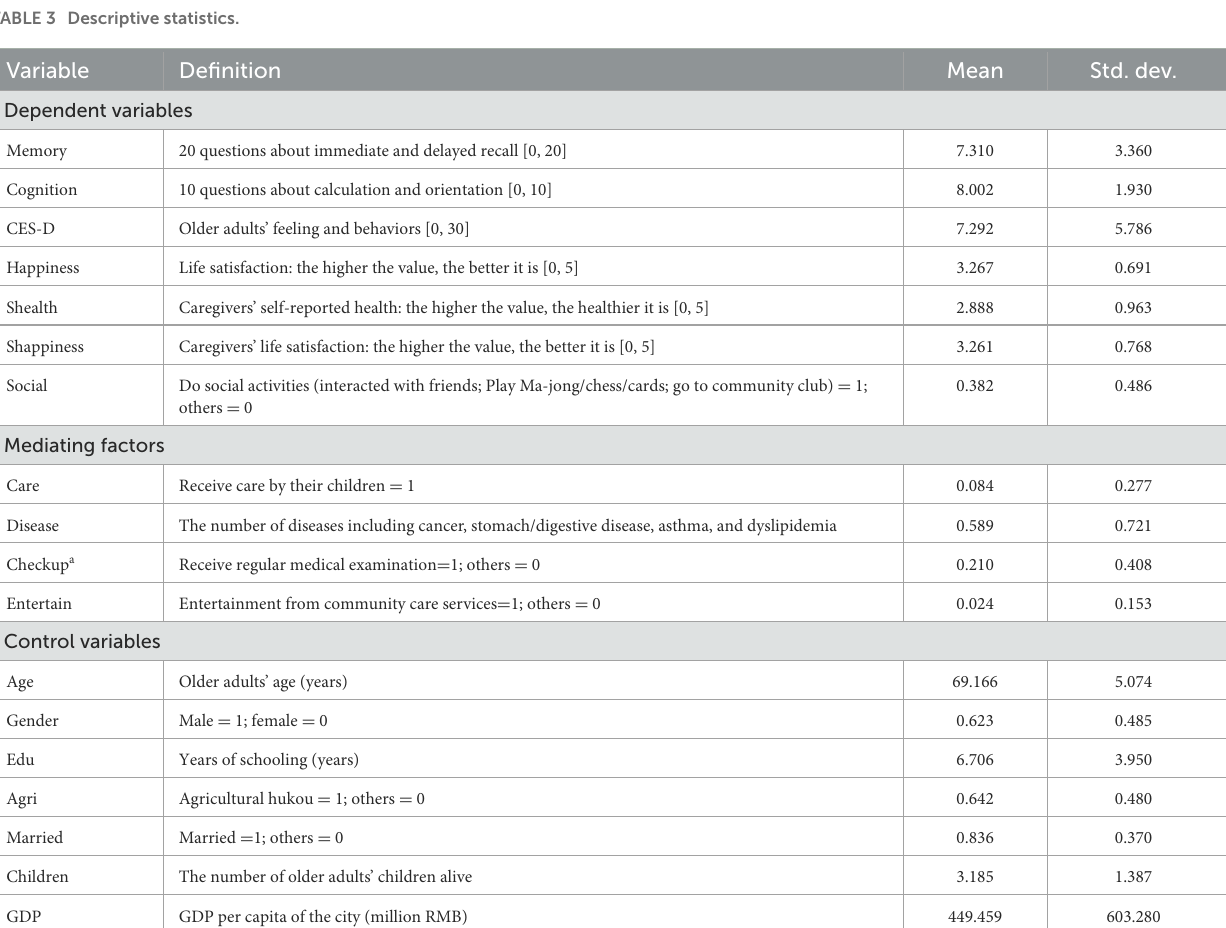
FIGURE1 Theoretical framework.